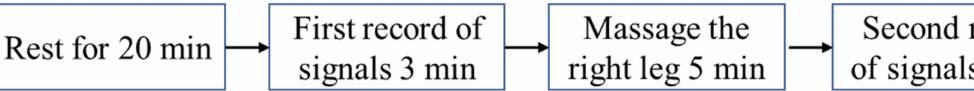
Figure 3. The experimental stages.